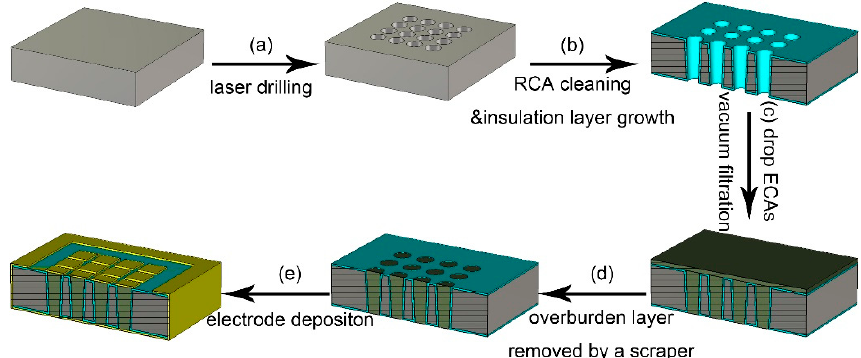
Figure 1. Schematic images of the TSVs fabrication process.